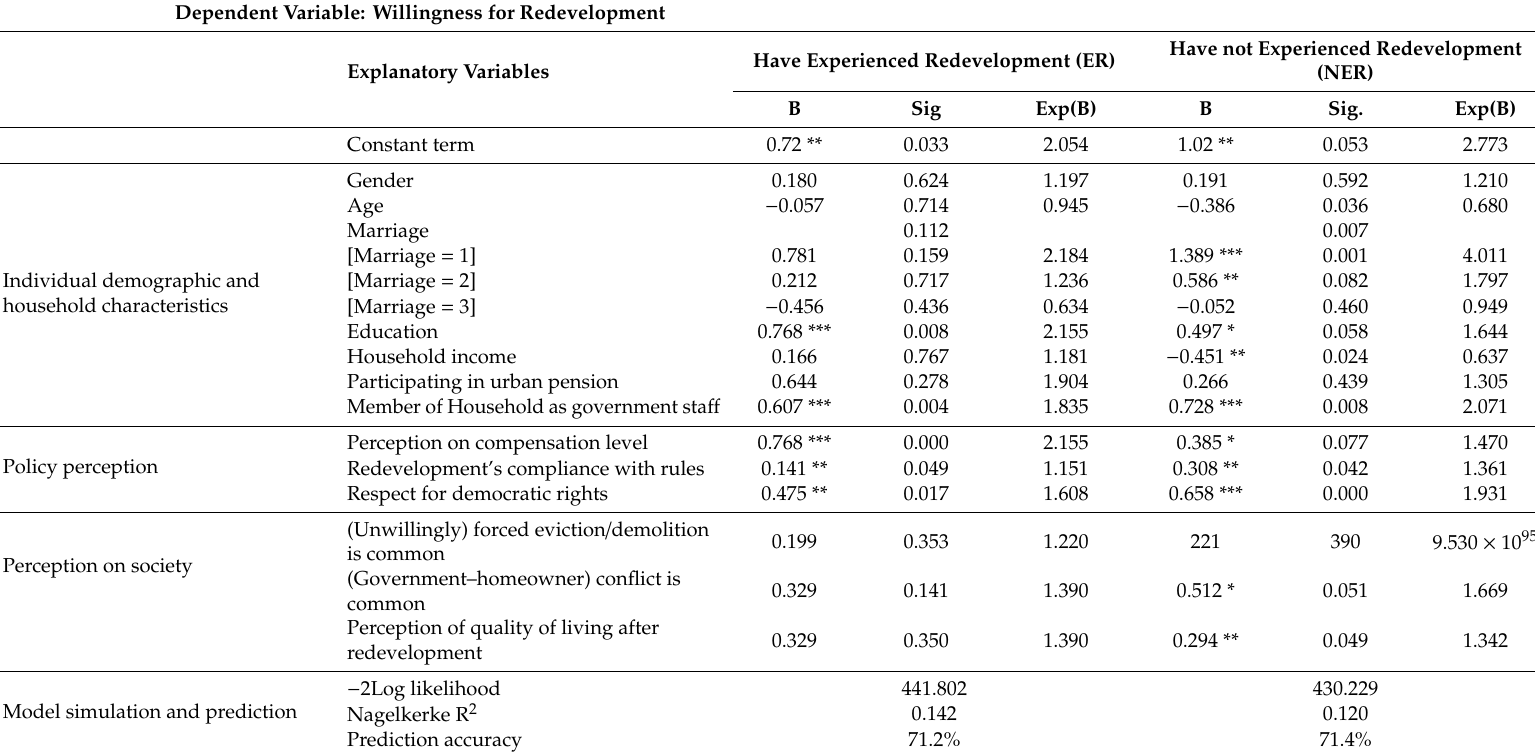
Table 8. Redevelopment Experience and Willingness for